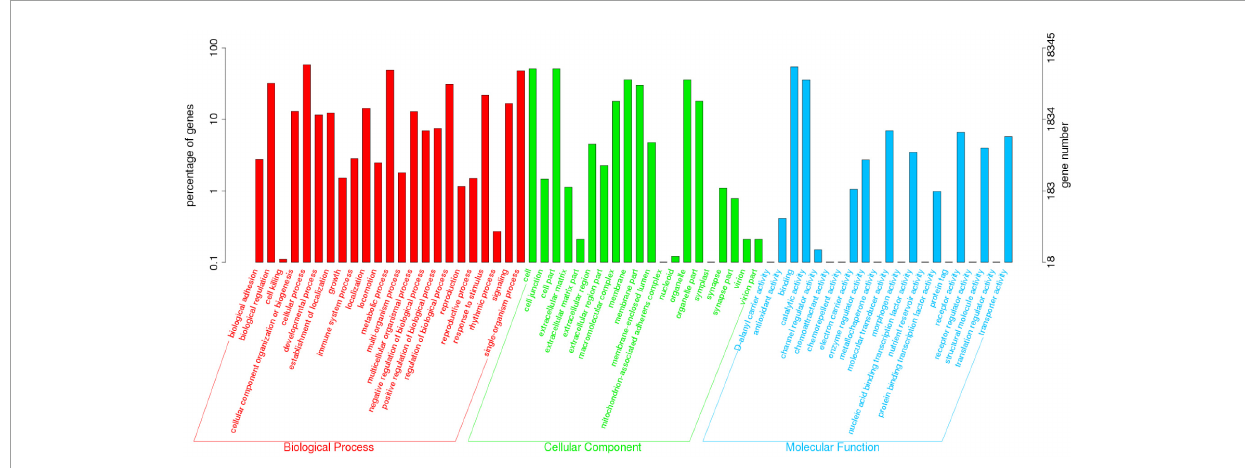
FIGURE1 Eukaryotic Ortholog Group (KOG) classification of the Unigenes in O. graminea . Different letters and colors were used to represent different KOG function classes, and the vertical axis represented the number of genes.